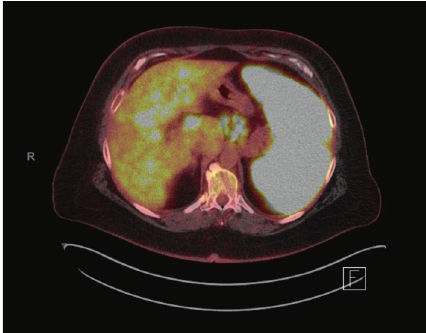
Figure 2: 2/2017 significant abnormal radiotracer uptake within the spleen and scattered foci of hypermetabolic activity within the liver.